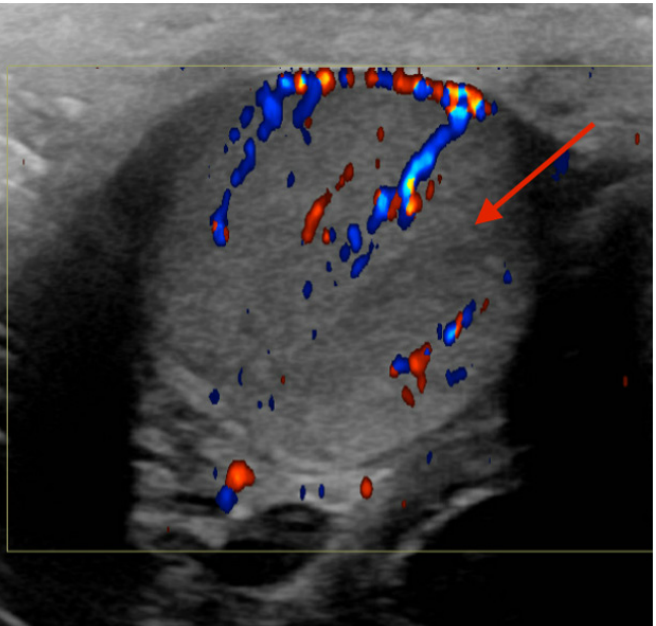
Image 2. A hypoechoic wedge-shaped area (arrow) showing no flow on ultrasound with Doppler in this